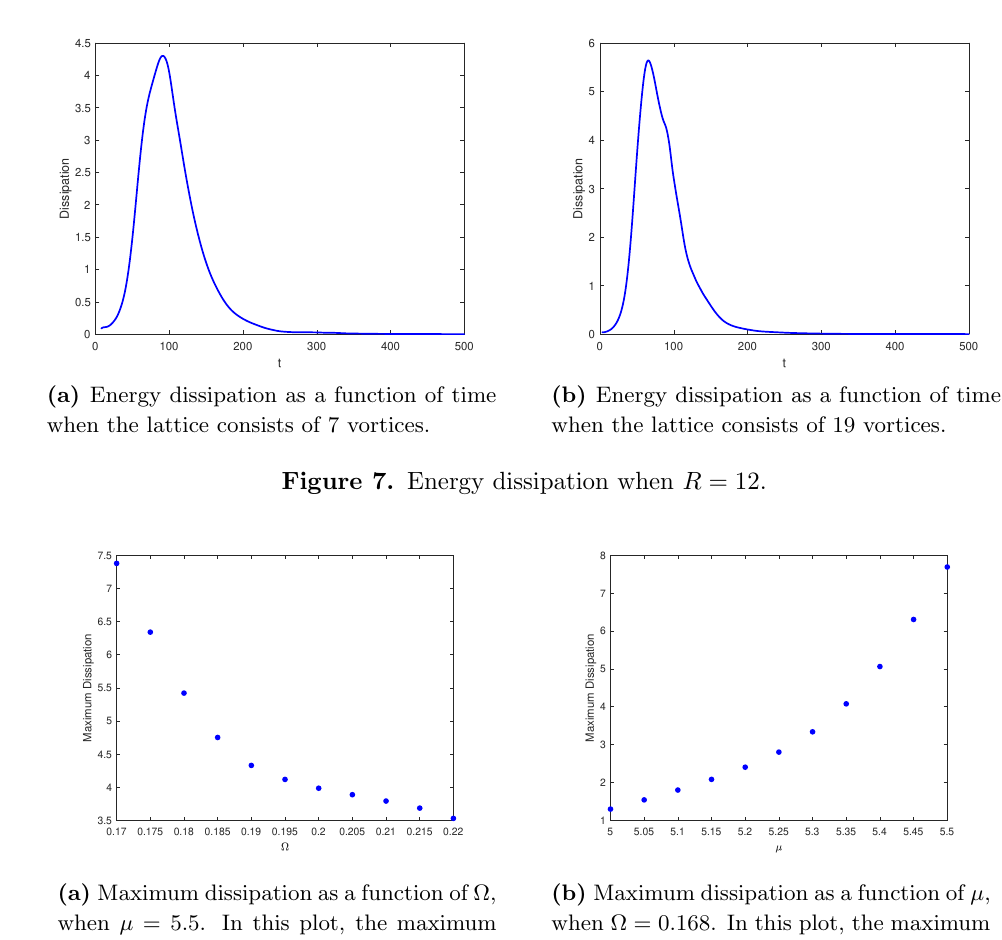
Figure 8. Maximum dissipation as a function of (cid:10) and (cid:22) , when R =